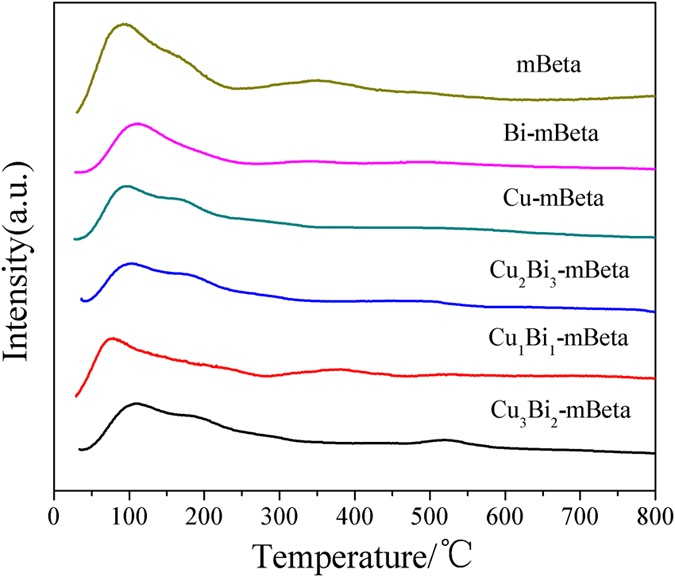
NH3-TPD profiles of mBeta, Cu-mBeta, Bi-mBeta and CuxBiy-mBeta samples.